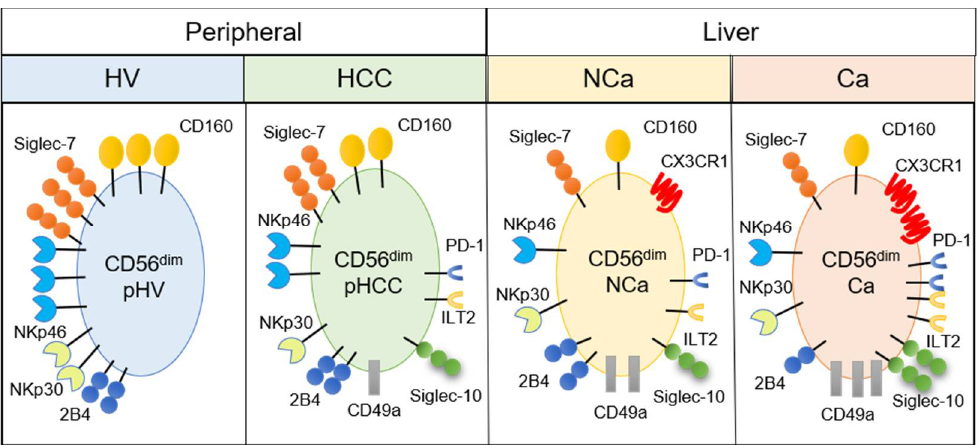
Figure 5. Summary of phenotypic alterations in peripheral and intrahepatic CD56 dim NK cells from HCC patients. CD56 dim , CD56 dim NK cells; pHV, in the peripheral blood of healthy volunteers; pHCC, in the peripheral blood of HCC patients; NCa, from noncancerous adjacent liver tissues; Ca, in HCC tissues.